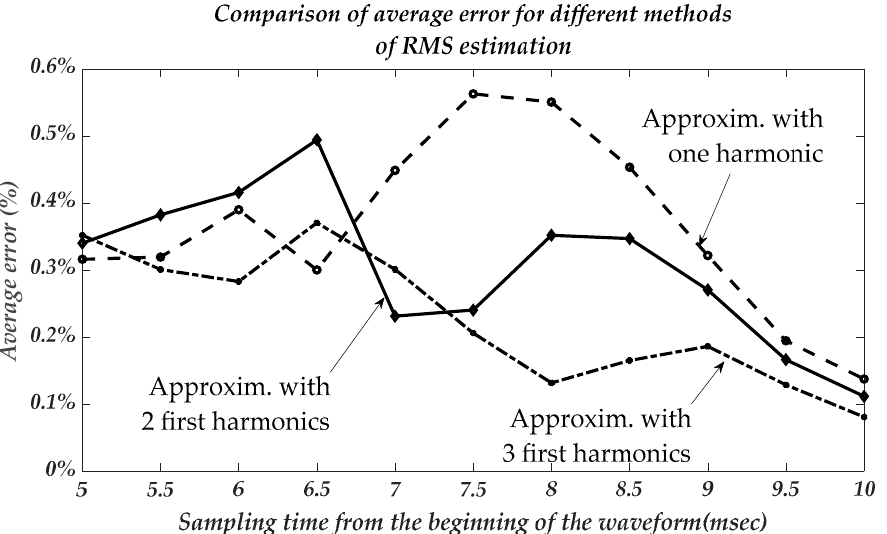
Figure 8. The average relative route-mean-square error for one-two, and three-harmonics represen- tations as per sampling time.